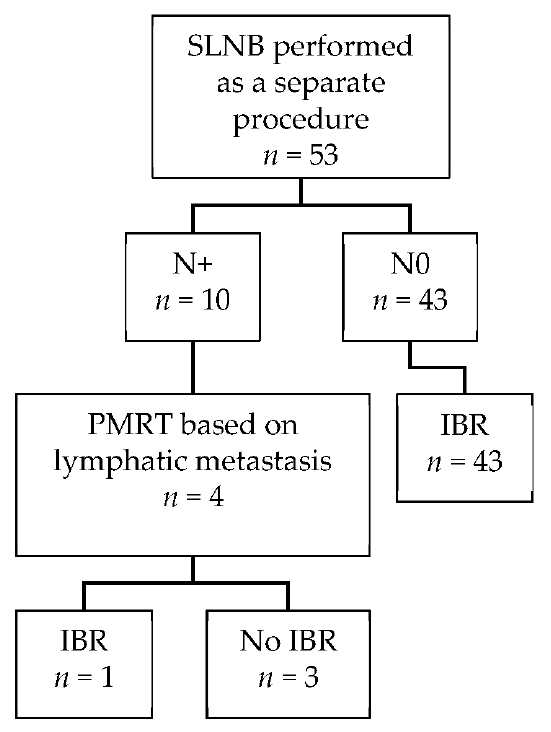
Figure 2. Flow chart of patients who underwent sentinel lymph node biopsy (SLNB) as a separate axillary staging procedure, patients who receive postmastectomy radiation therapy (PMRT) based on lymphatic metastasis in staged SLNB, and number of patients who receive immediate breast reconstruction (IBR) or no IBR. Abbreviations: SLNB , sentinel lymph node biopsy; N+, node-positive; N0, node-negative; PMRT, postmastectomy radiation therapy; IBR, immediate breast